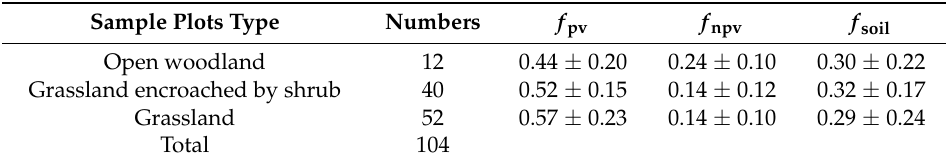
Table 2. Characteristics of sample plots. Values shown for f pv , f npv , and f soil are average ± standard